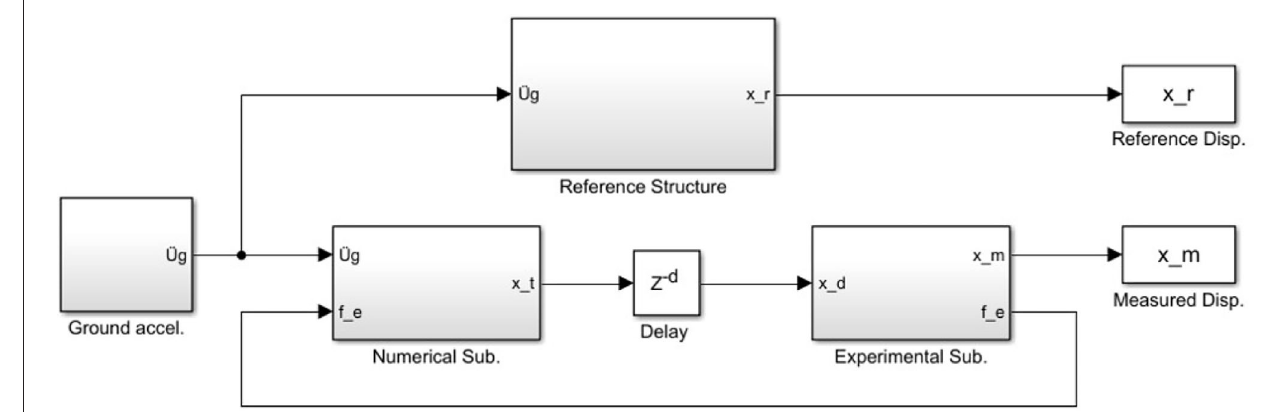
FIGURE 4 | Reference structure and RTHS partitioning with delay.